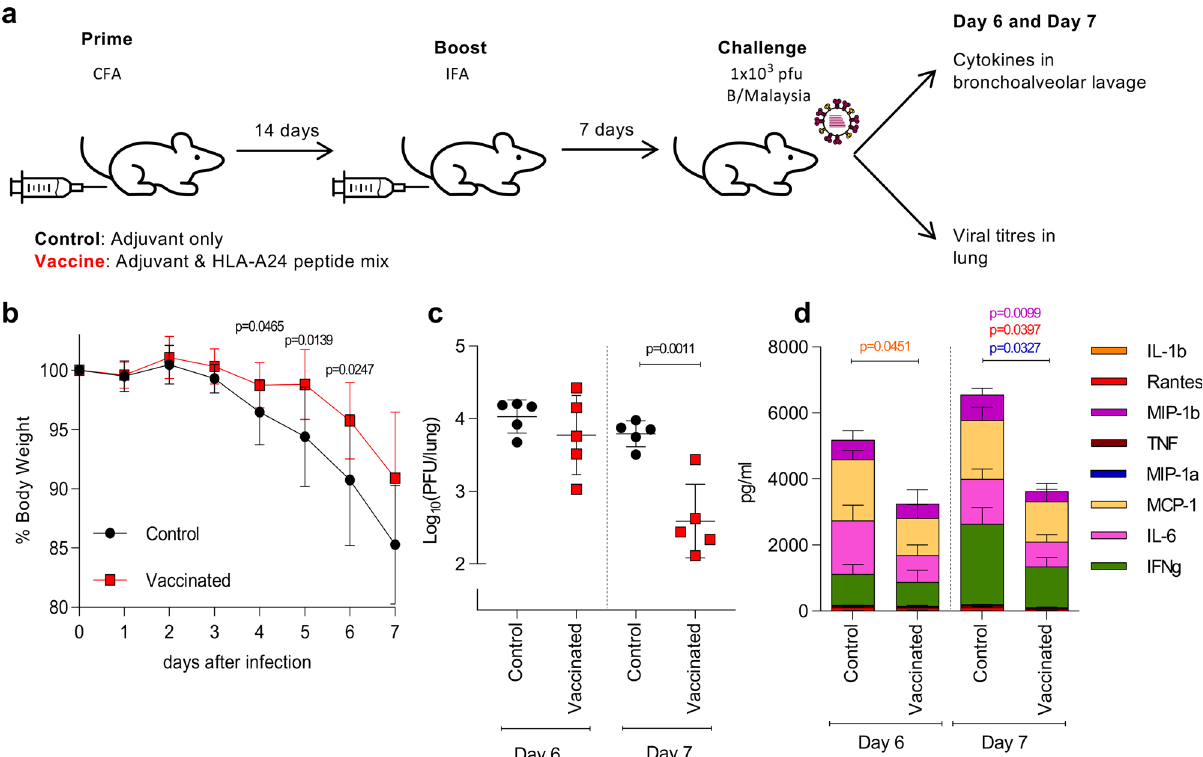
Fig. 5 Protection of HDD.24 mice by vaccination with immunogenic A24 peptides. a Mice were vaccinated with 3 immunogenic IBV peptides (NP 164 , NP 392 , NA 32 ) in adjuvant CFA or CFA alone (control). 14 days post-priming, immune responses were boosted with peptides/IFA or IFA alone. 7 days after the boost, mice were challenged with a high dose of 1 × 10 3 pfu B/Malaysia. Bronchoalveolar lavage and lungs were collected on days 6 and 7 post infection. b % bodyweight of mice after virus challenge at different days after infection. c Virus titer from homogenized lungs on days 6 and 7 post challenge. d Cytokine levels in BAL on day 6 and 7. Colored stars indicate signi fi cant differences between control and peptide-vaccinated groups. b – d Statistical signi fi cance was calculated using an unpaired two-tailed t-test with * p < 0.05 ( n = 5 animals per group, 1 experiment). Mean values are shown with ±SD ( b , c ) or + SD ( d